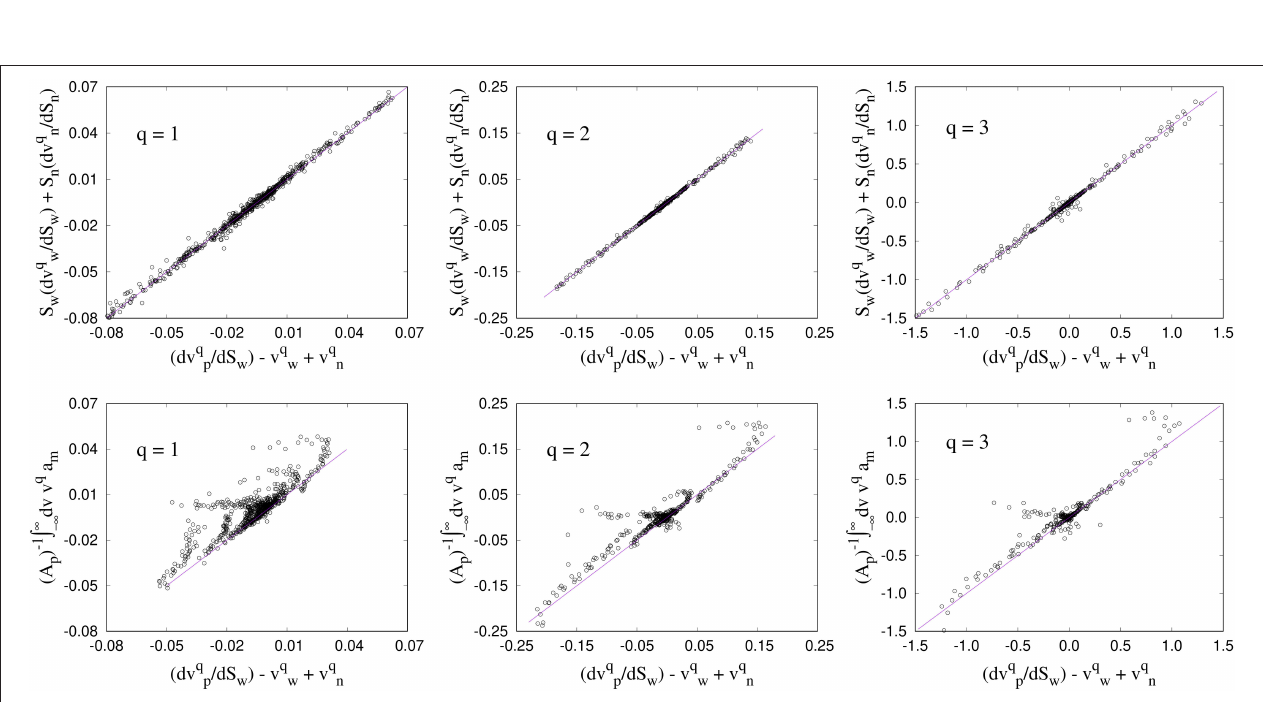
2 and 3, the units for v q m will be mm 2 /s and mm 3 /s, =